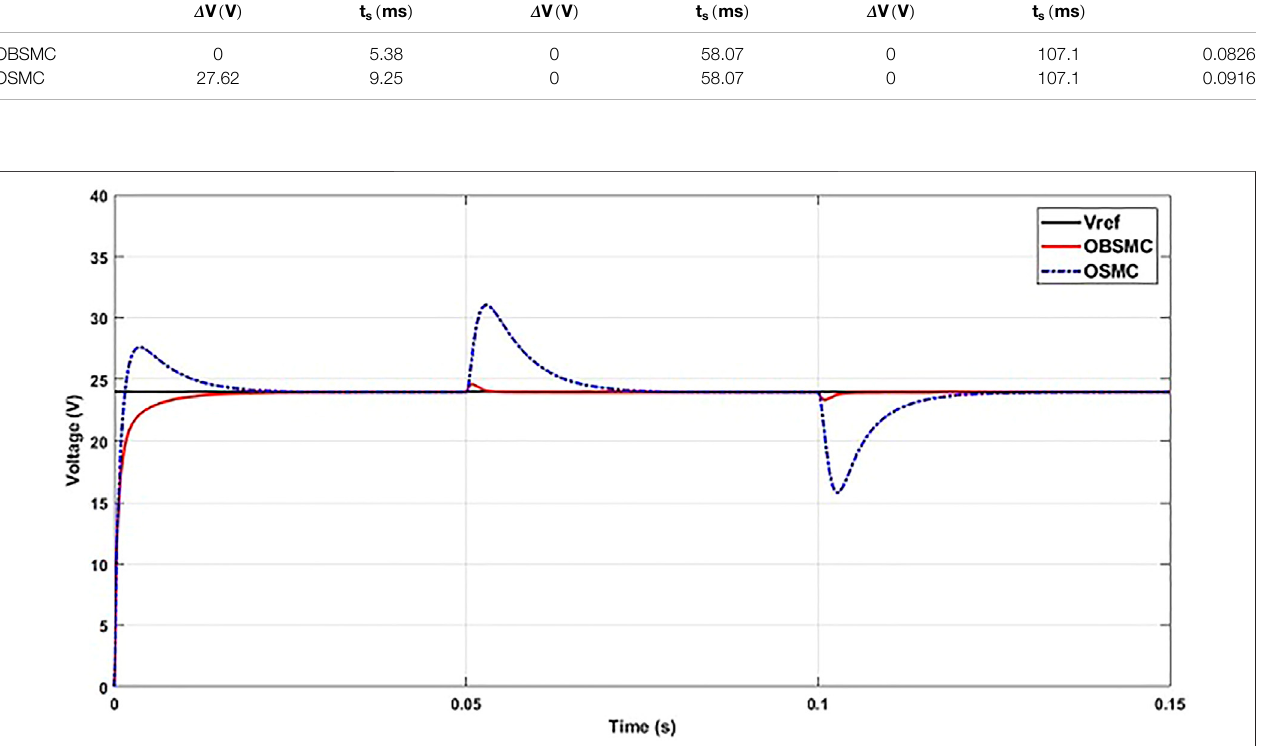
FIGURE 7 | Output voltage of the converter for input voltage variations.